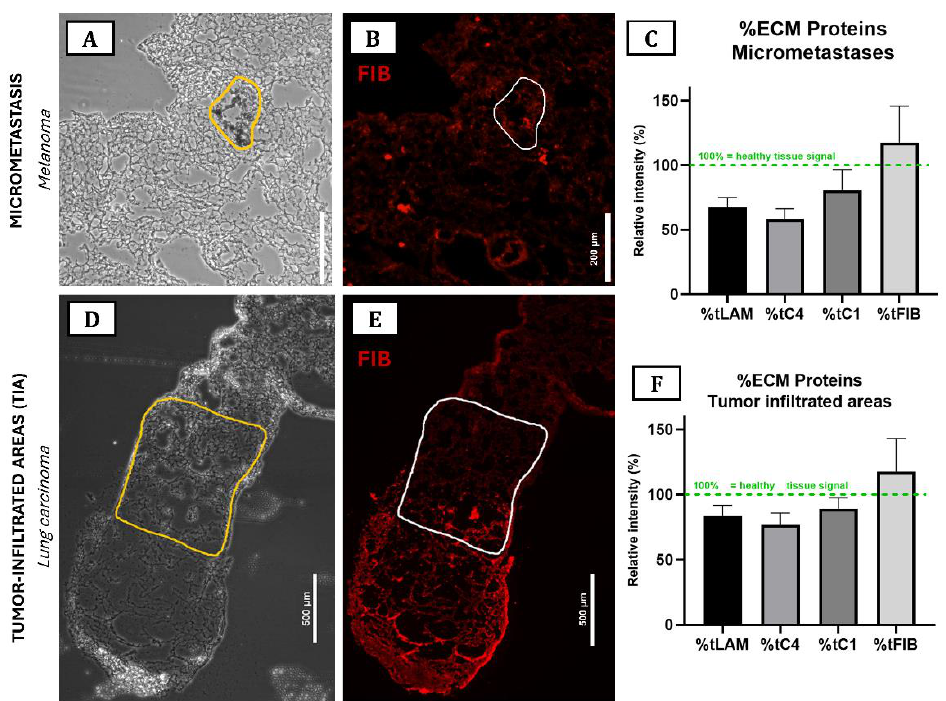
Figure 5. ECM protein staining and quantification of early-stage invasion areas in CAR metastases (tumor-infiltrated areas, TIA ( D – F )) and MEL metastases (micrometastases ( A – C )). Representative phase contrast ( A , D ) and corresponding fluorescent images ( B , E ) of acellular tumor sections (20μm) after fibronectin immunostaining (red). The regions of interest were traced on the phase contrast images (yellow selection) and applied to the corresponding fluorescent image (white selection), and the signal was quantified. This quantification was performed for fibronectin, collagen I and IV, and laminin in micrometastases ECM ( C ) and TIA ( F ). The intensity of healthy lung ECM was normalized to 100% (green line).